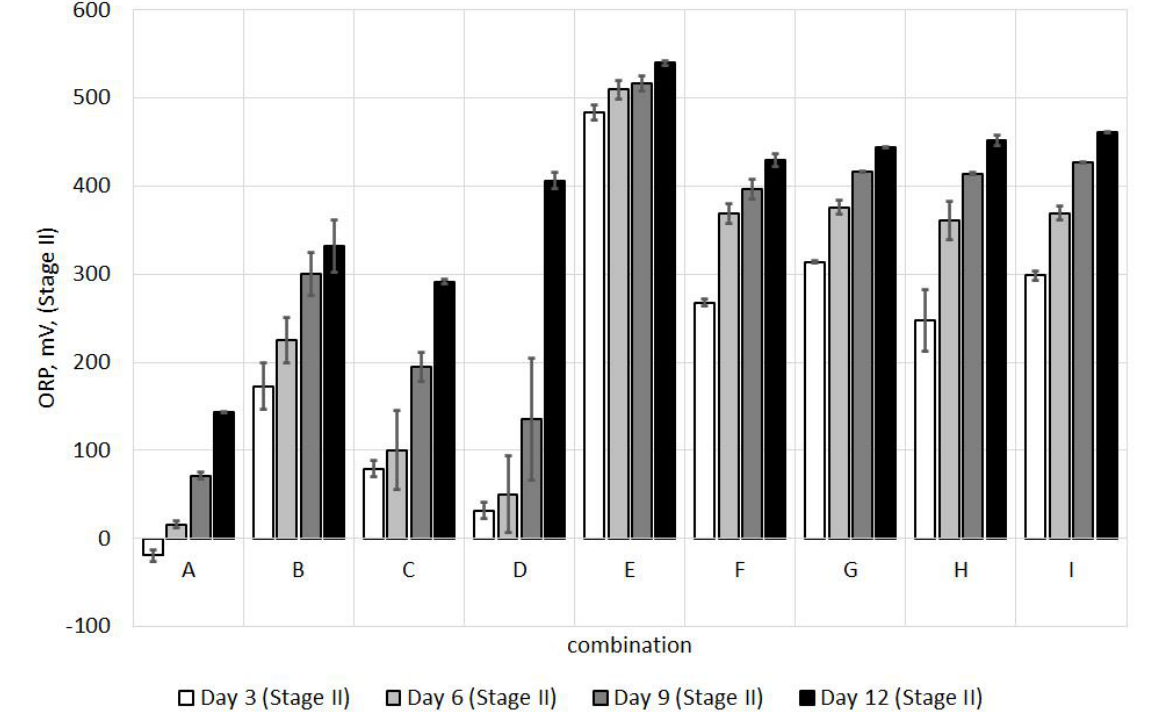
Figure 4. The oxidation and reduction potential of the samples analyzed in Stage II.